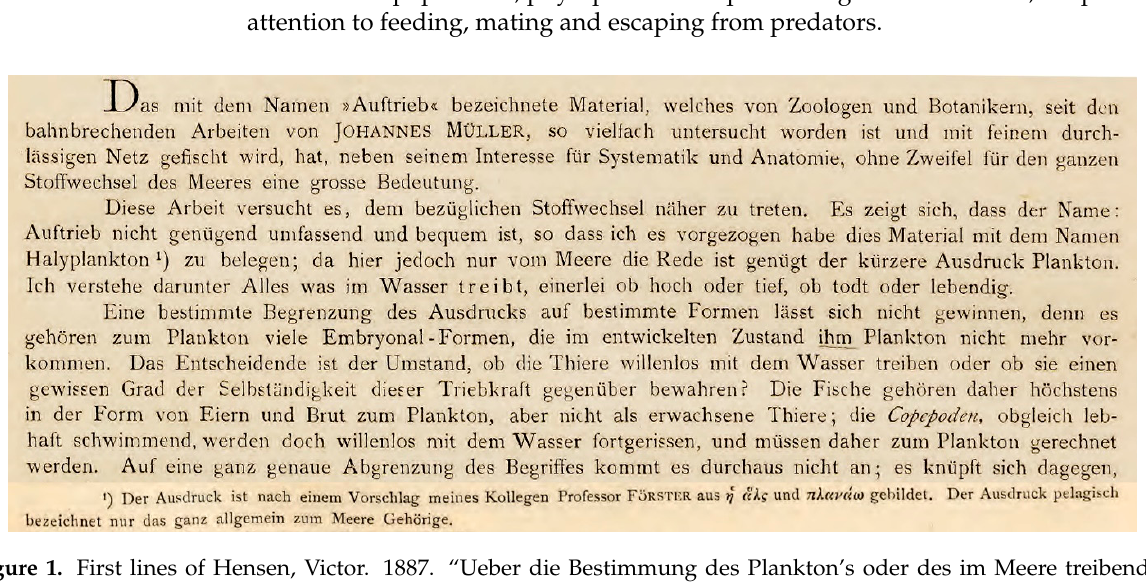
Figure 1. First lines of Hensen, Victor. 1887. “Ueber die Bestimmung des Plankton’s oder des im Meere treibenden Materials an Pflanzen und Thieren”. Bericht der Kommission zur wissenschaftlichen Untersuchungen der deutschen Meere, in Kiel 5: 1–107, 6 pls.